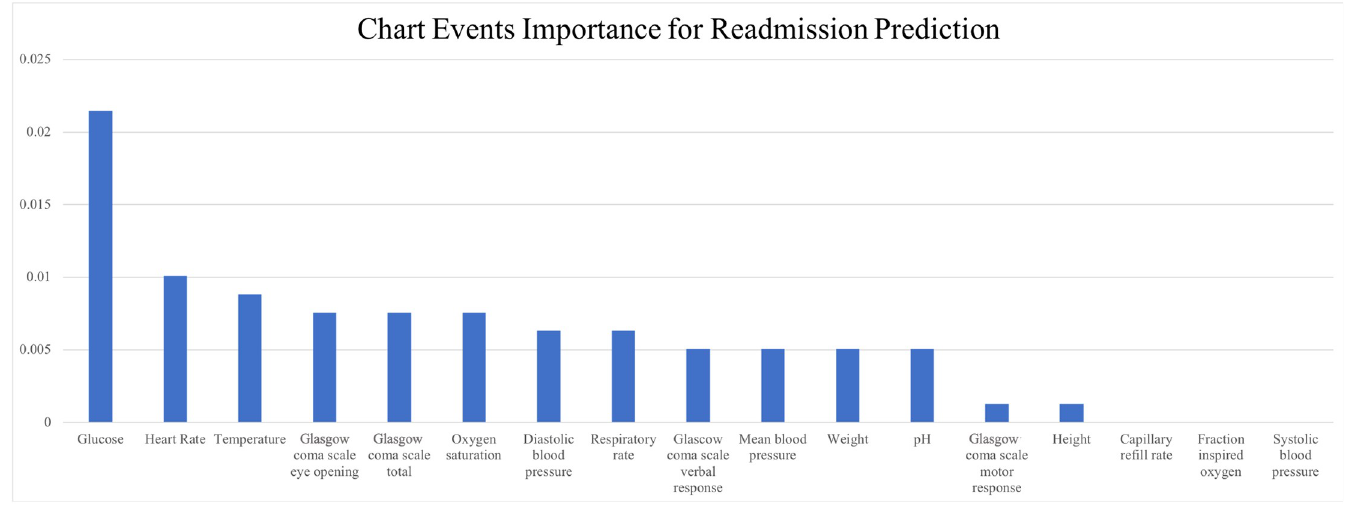
Fig 7. The results of feature ablation test. The importance of chart events for predicting the ICU readmission. The y-axis shows the changing ratio of the prediction results after we replace the original feature with its normal value.